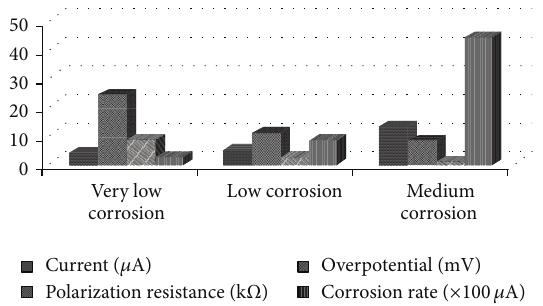
for very low, low, and corr